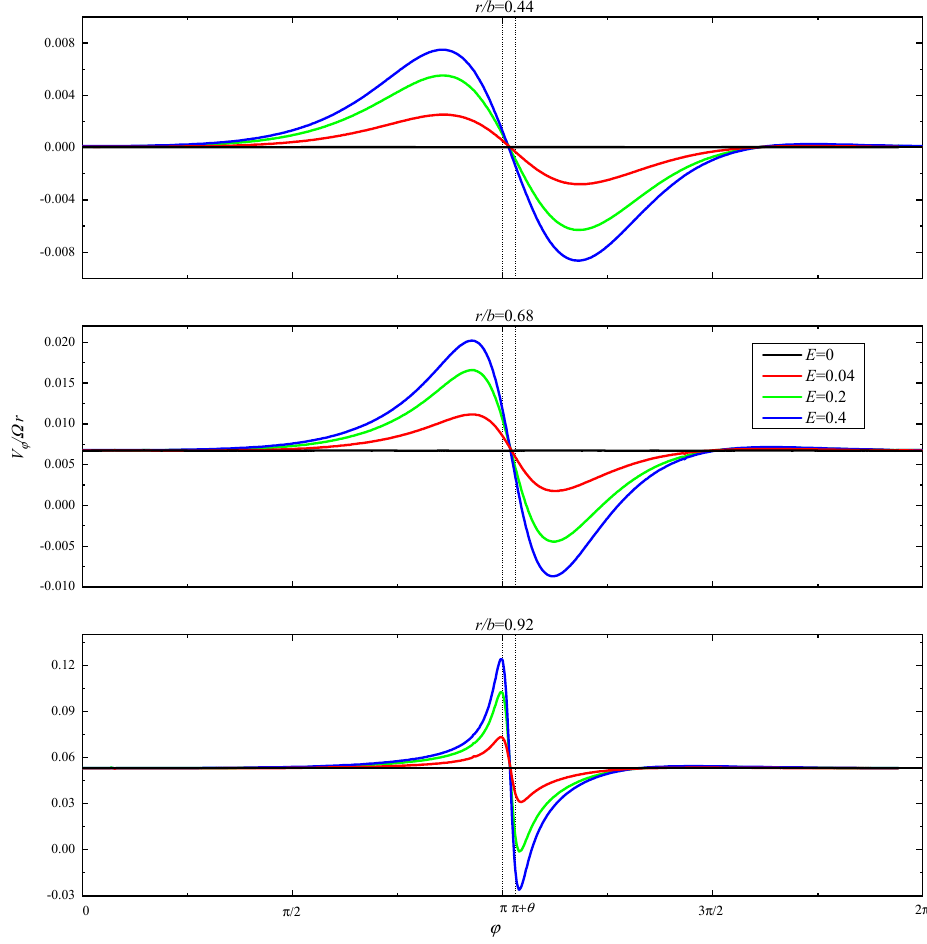
Figure 8. β curves for C w = 10137, Re ϕ = 5.12 × 10 5 , θ = 0.1 at z / s =